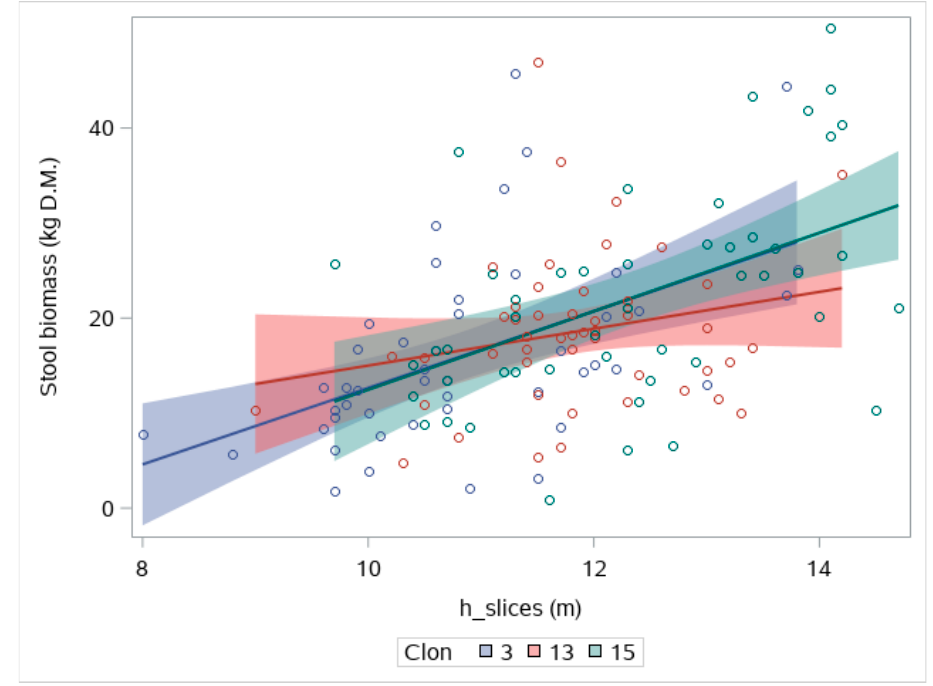
Figure 6. Effect of clone over the relation between individual stool biomass and the height derived from TLS slicing ( H_slice ). Shaded indicate 95% confidence intervals.